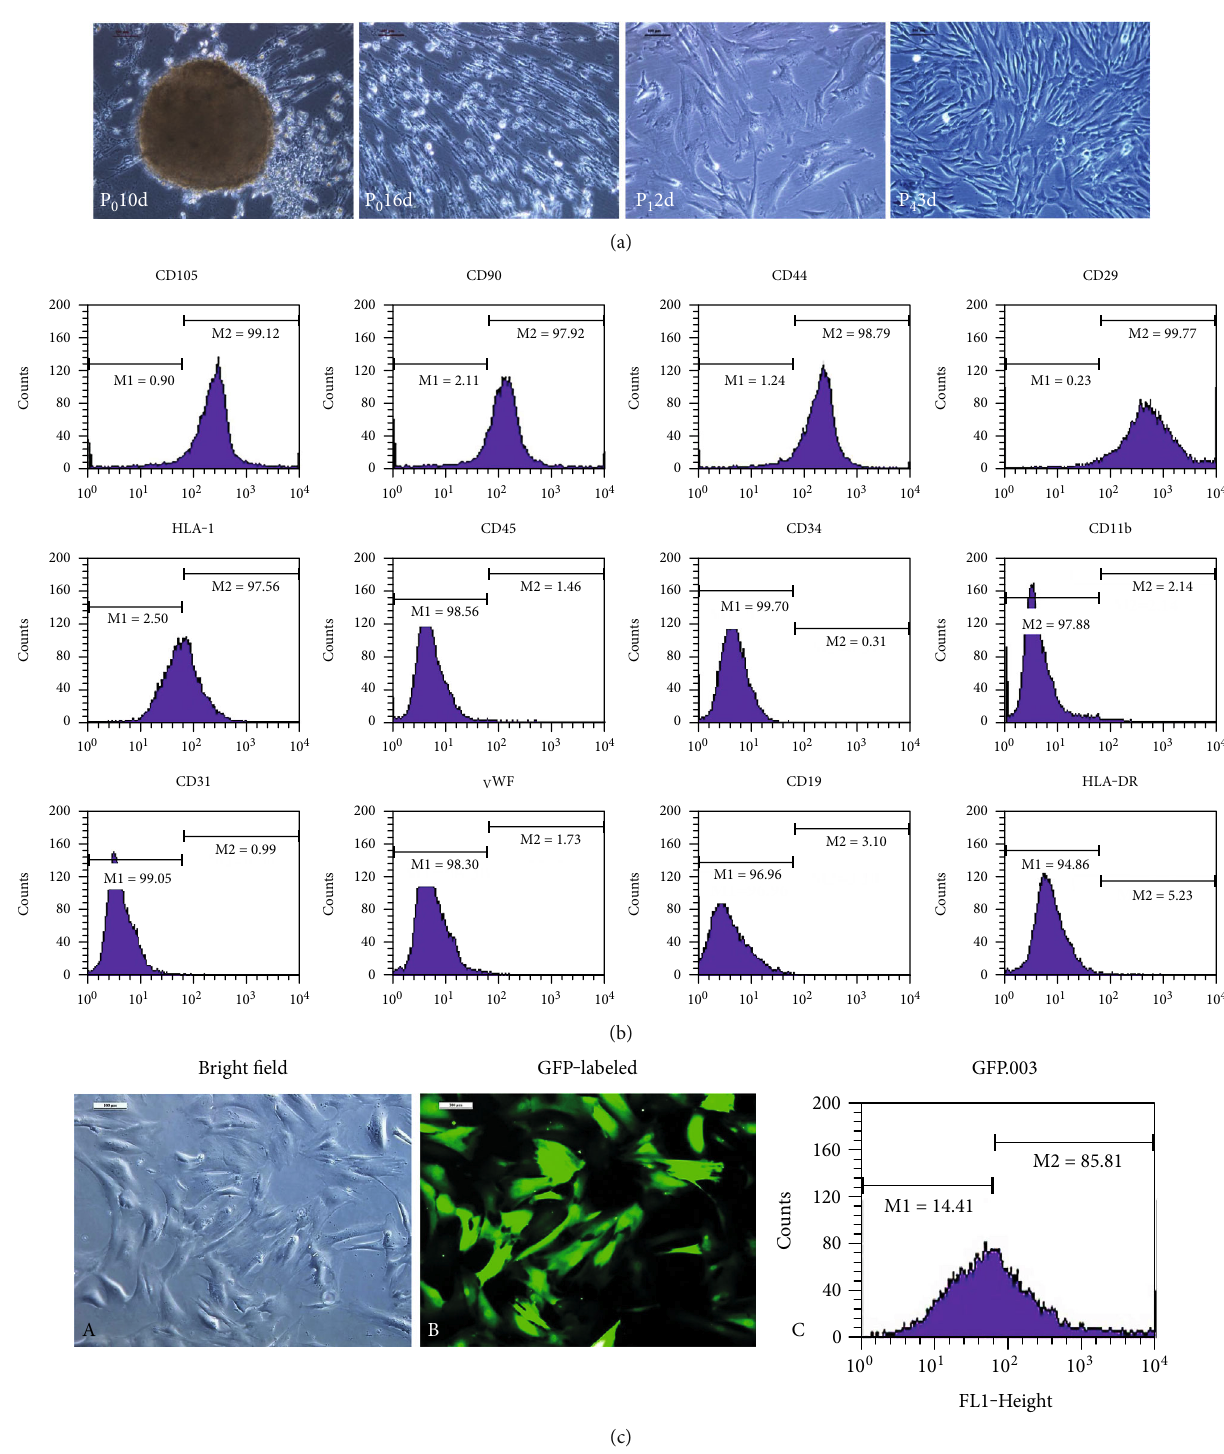
Figure 1: The hUCMSC isolation, culture, and identi fi cation. (a) The hUCMSCs were isolated and cultured by adherent method, as well as grew in vortex shape. (b) The hUCMSCs are positive expression of CD105, CD90, CD44, and CD29 and negative expression of CD45, CD34, CD11b, CD31, vWF, CD19, and HLA-DR using fl ow cytometry. (c) The hUCMSCs were labeled with green fl uorescent protein (GFP) using a lentiviral strategy